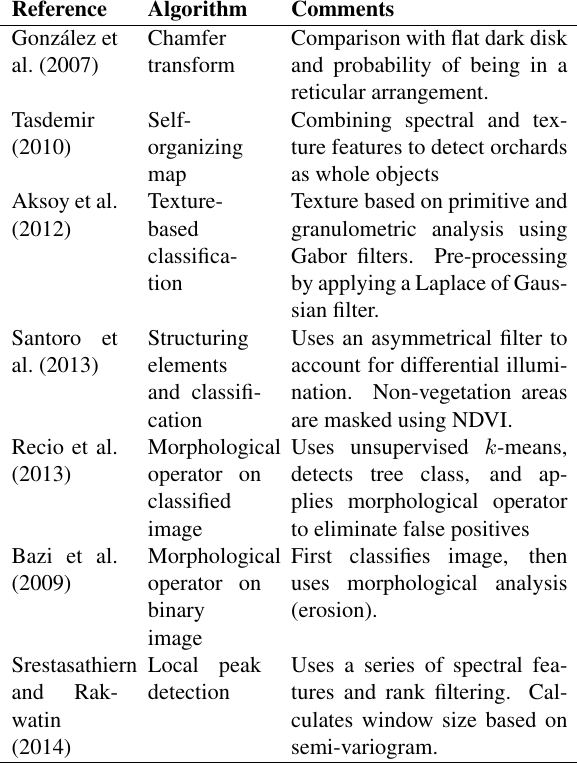
Table 1: List of articles dedicated to orchard tree detection us- ing VHR images ( ≤ 1 m) along with their respective generic ap-